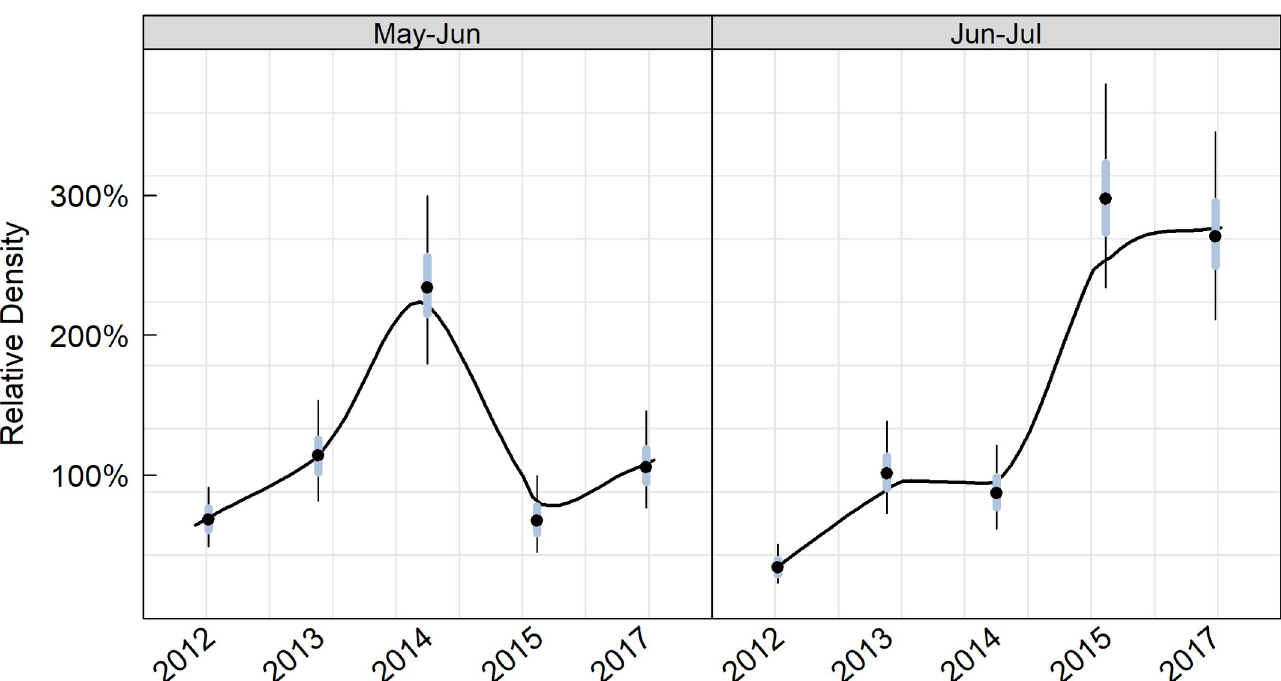
Fig 6. Marbled murrelet density by sampling window and year. Violin plot depicting the posterior distribution of annual marbled murrelet density (km 2 ) by 2-month survey window during the non-breeding season. Black trend line derived from locally weighted sum of square regression (loess) fit to all posterior draws.